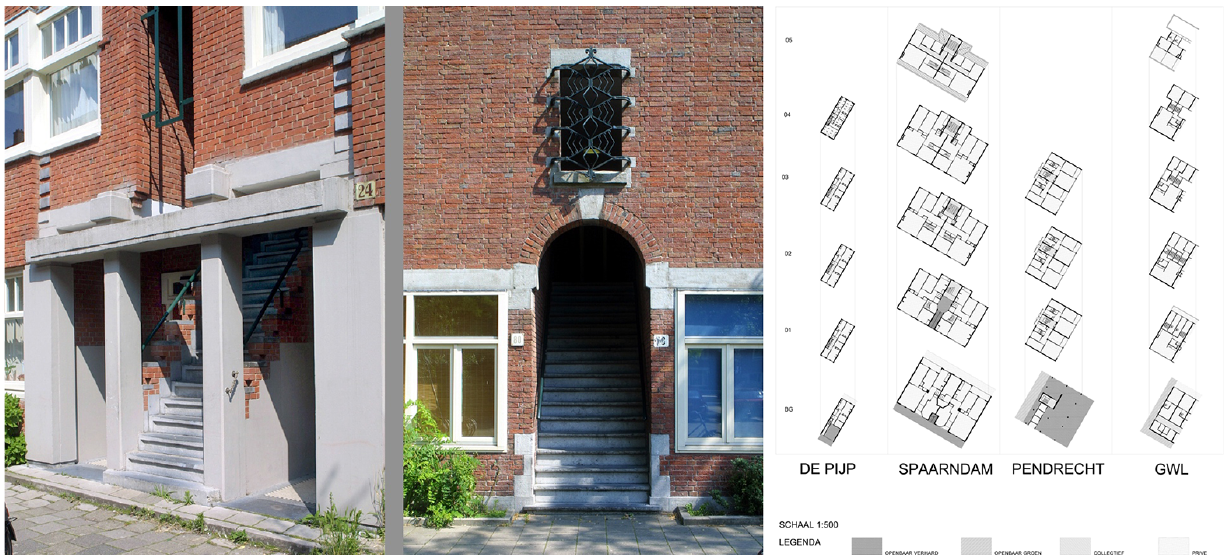
Figure 7. Grounded-ness, the tradition of the own front door. From left to right: Photographic examples of the own front door in in Amsterdam Zuid; comparison of Amsterdam access types ranging from De Pijp, Spaarndammerbuurt, Pendrecht, and GWL terrain in Amsterdam and Rotterdam. Source: